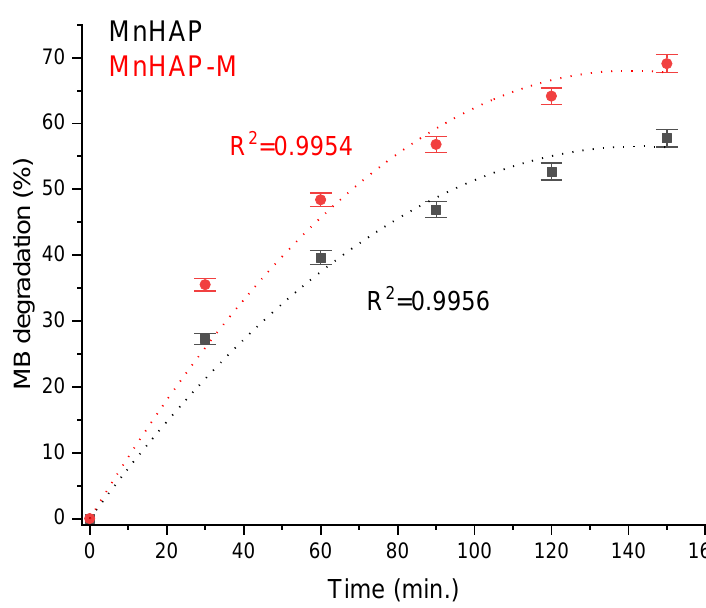
Figure 7. MB photodegradation efficiency under xenon light exposure.